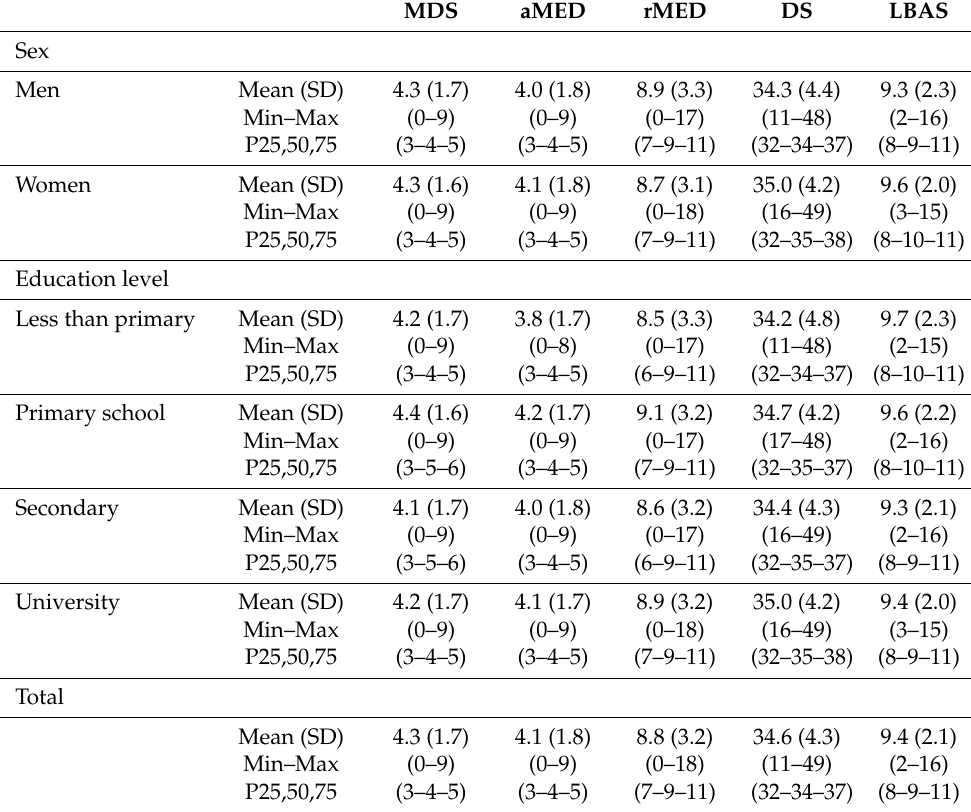
Table 2. Descriptive analysis of Mediterranean diet pattern adherence indexes ( n = 3640).